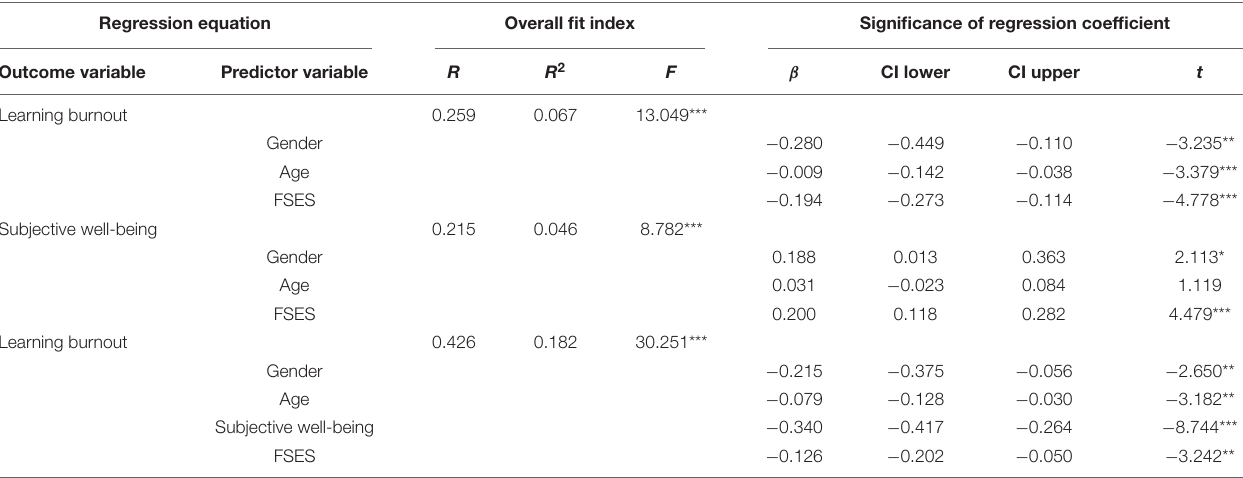
TABLE 3 | Mediating model test of subjective